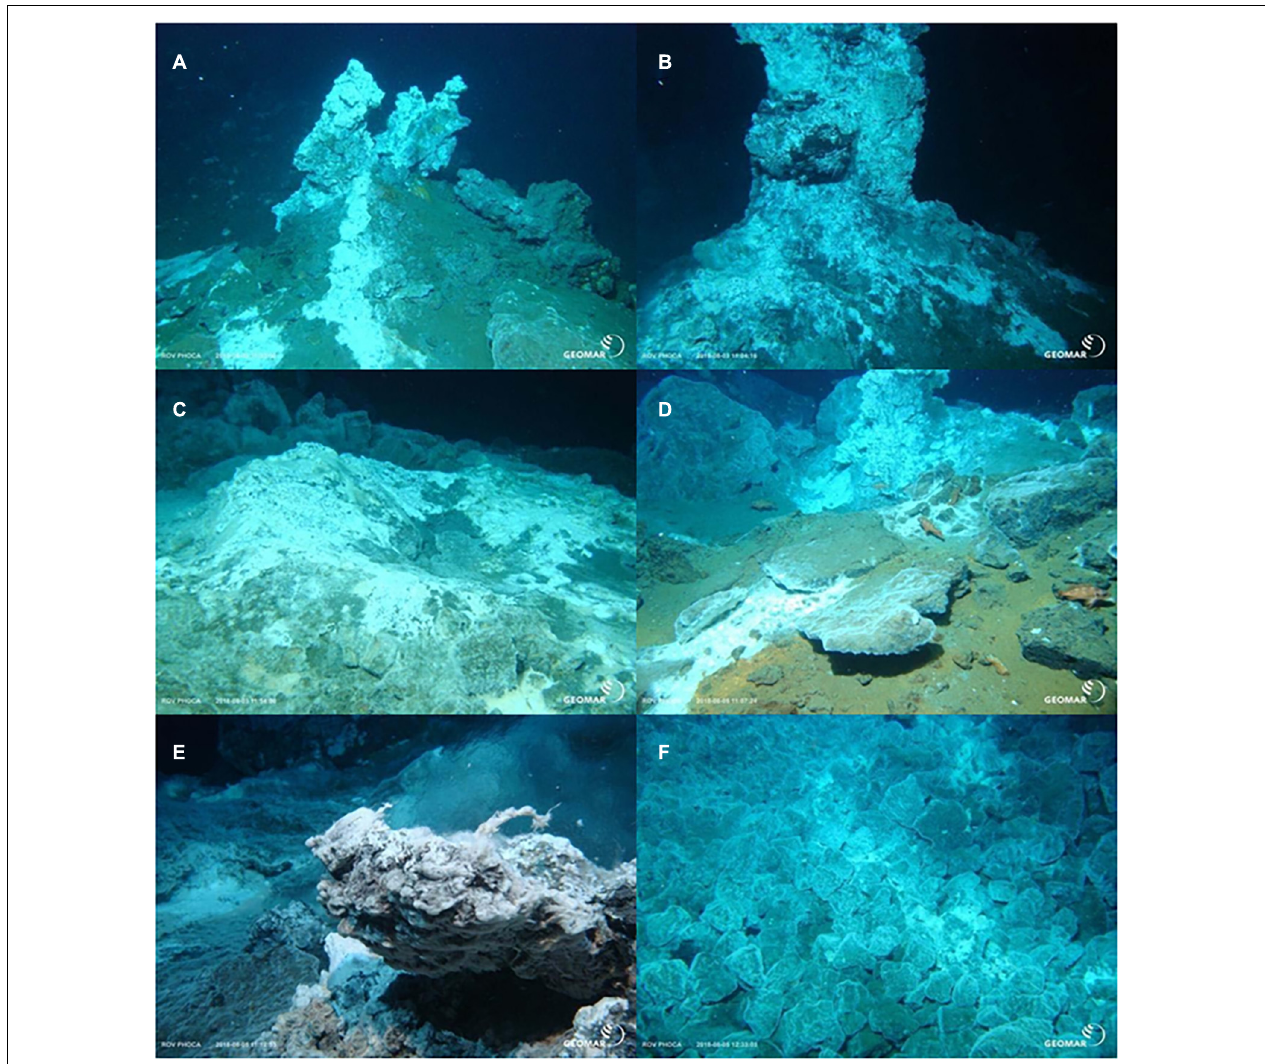
FIGURE 2 | (A) Small anhydrite chimney with associated bacterial mats located on top of a small mound at Hafgufa (212ROV-T11:33). (B) Base of largest chimney (2.5 m height) observed in the Steinahóll area. The chimney at Hafgufa is largely composed of anhydrite with minor pyrite/marcasite (212ROV-T11:04). (C) Small circular depression at Hafgufa with raised clay- rich rim covered in microbial mats. The elevated nature of the rim indicates a hydrothermal formation while anhydrite dissolution might be responsible for the formation of the depression (212ROV-T11:54). (D) Vent site at Lyngbakr with large anhydrite blocks, bacterial mats,